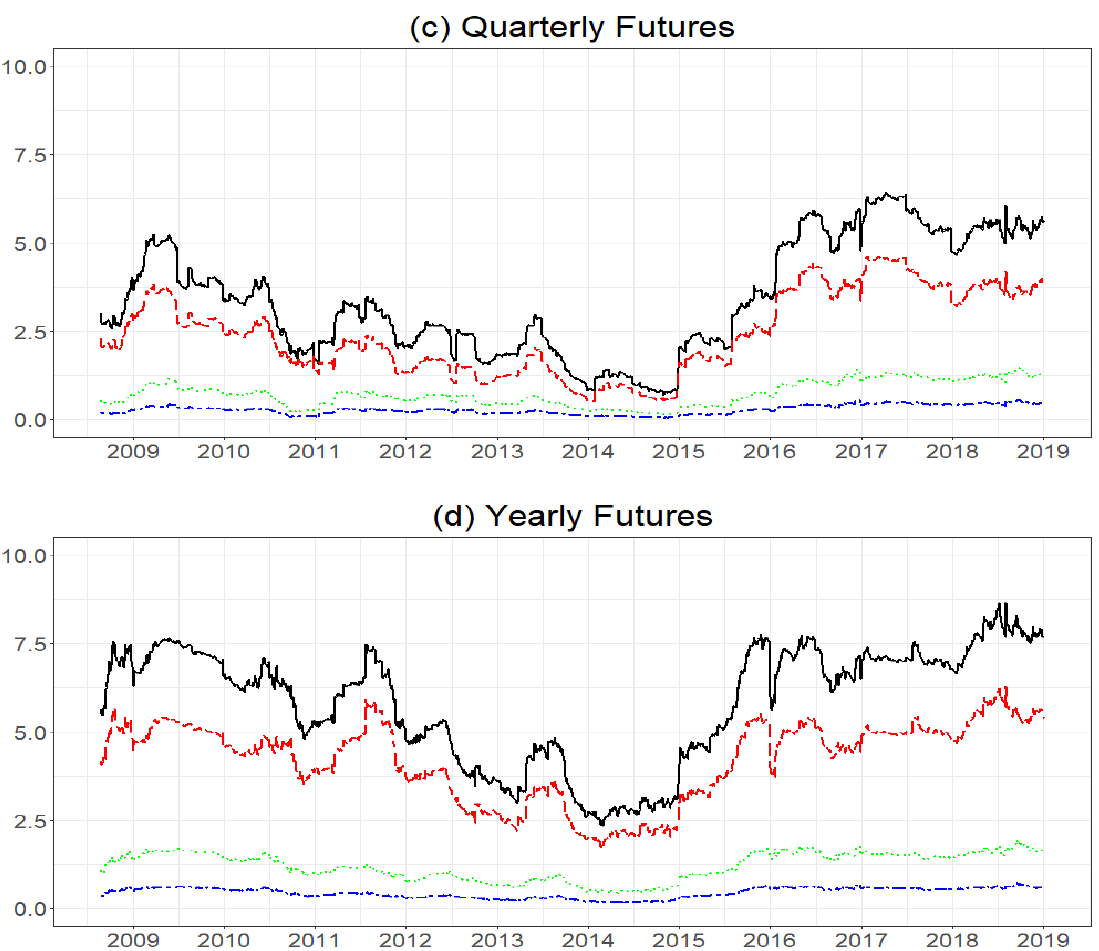
Figure 2. Diebold – Yilmaz approach (2012) directional return spillover (From) and Barunik – Krehlik methodology (2018) directional return spillover (From). Note: spot: EPEX Germany Baseload Spot; monthly futures: EEX Germany Baseload Monthly Futures; quarterly futures: EEX Germany Baseload Quarterly Futures; yearly futures: EEX Germany Baseload Yearly Futures.